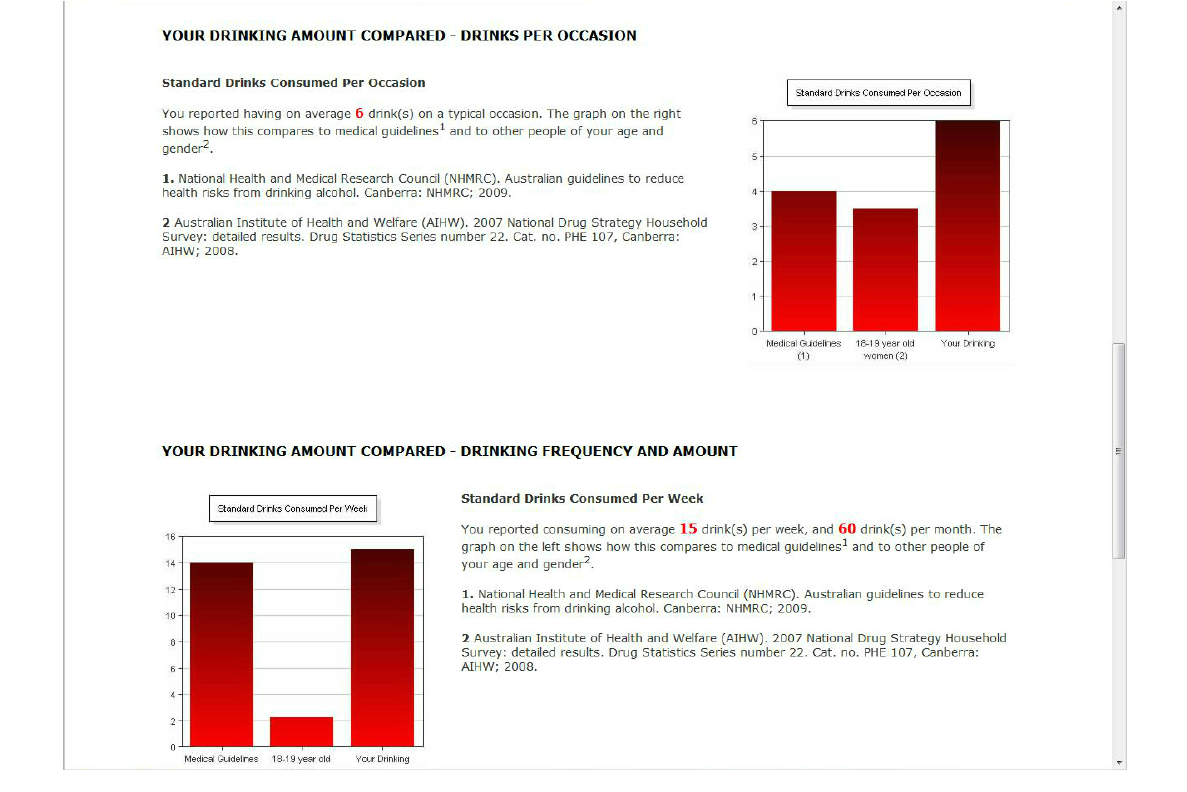
Figure 3. Screenshot from the pilot HOAP e-SBI program comparing a hypothetical participant’s (1) typical episodic consumption and (2) weekly consumption with (3) medical recommendations and (4) adults of the same age and